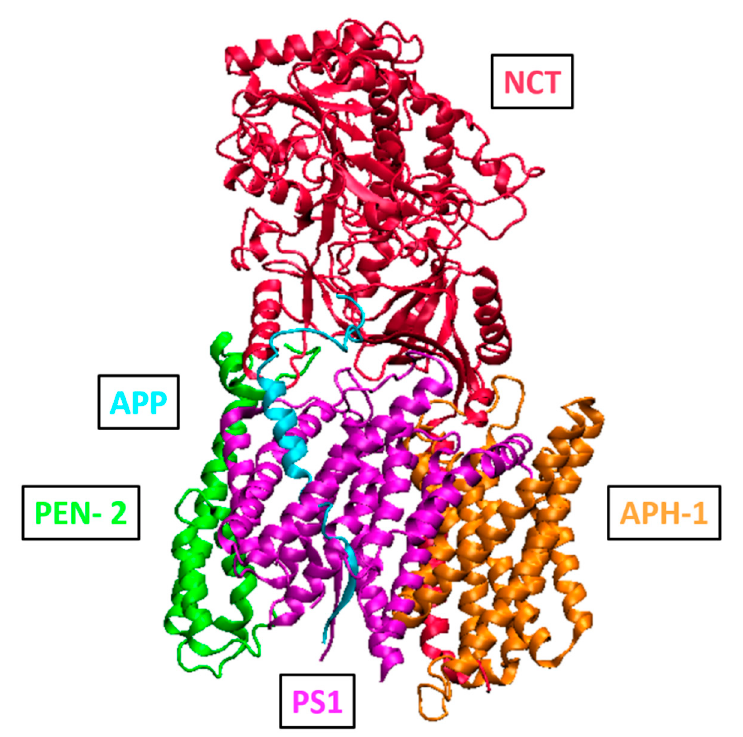
Figure 5. Three-dimensional structure of human γ -secretase complex (PDB ID: 6IYC).